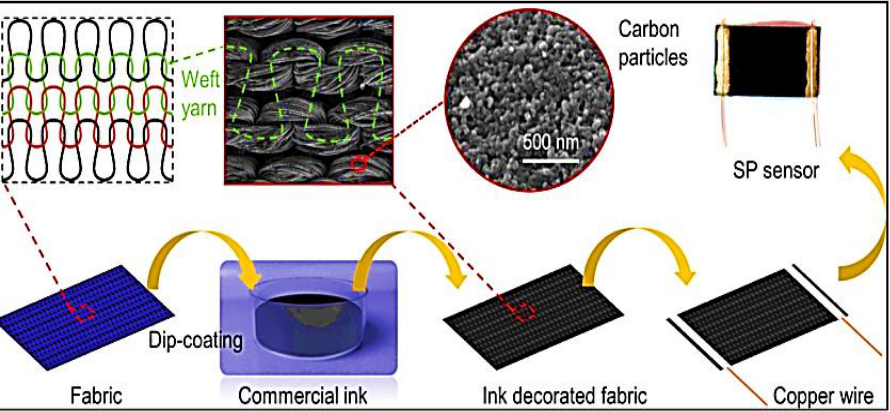
Figure 6. Schematic diagram illustrating the process of fabricating ink-decorated fabric strain sen- sor.